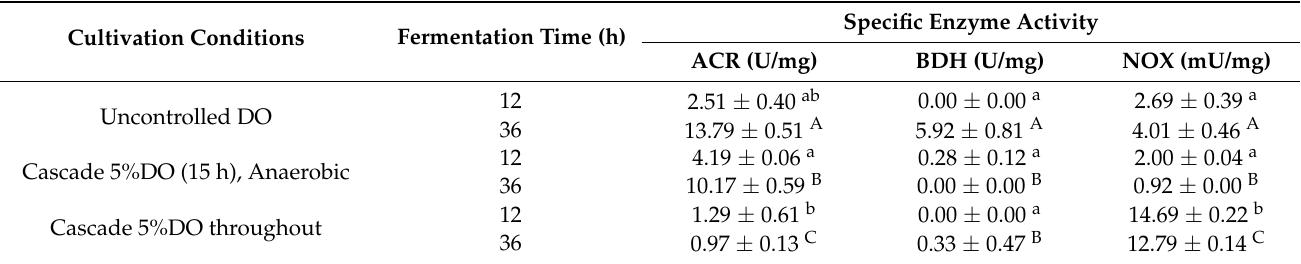
Indicated values are reported as means ± standard deviation. Values with the different superscript letters (within same column) are significantly different ( p < 0.05). Data are average values and standard deviations of duplicate measurements. All culture conditions were conducted in 5-L bioreactors at 30 ◦ C, pH 6.0 using MMRS with sucrose 20 g/L and corn steep liquor 20